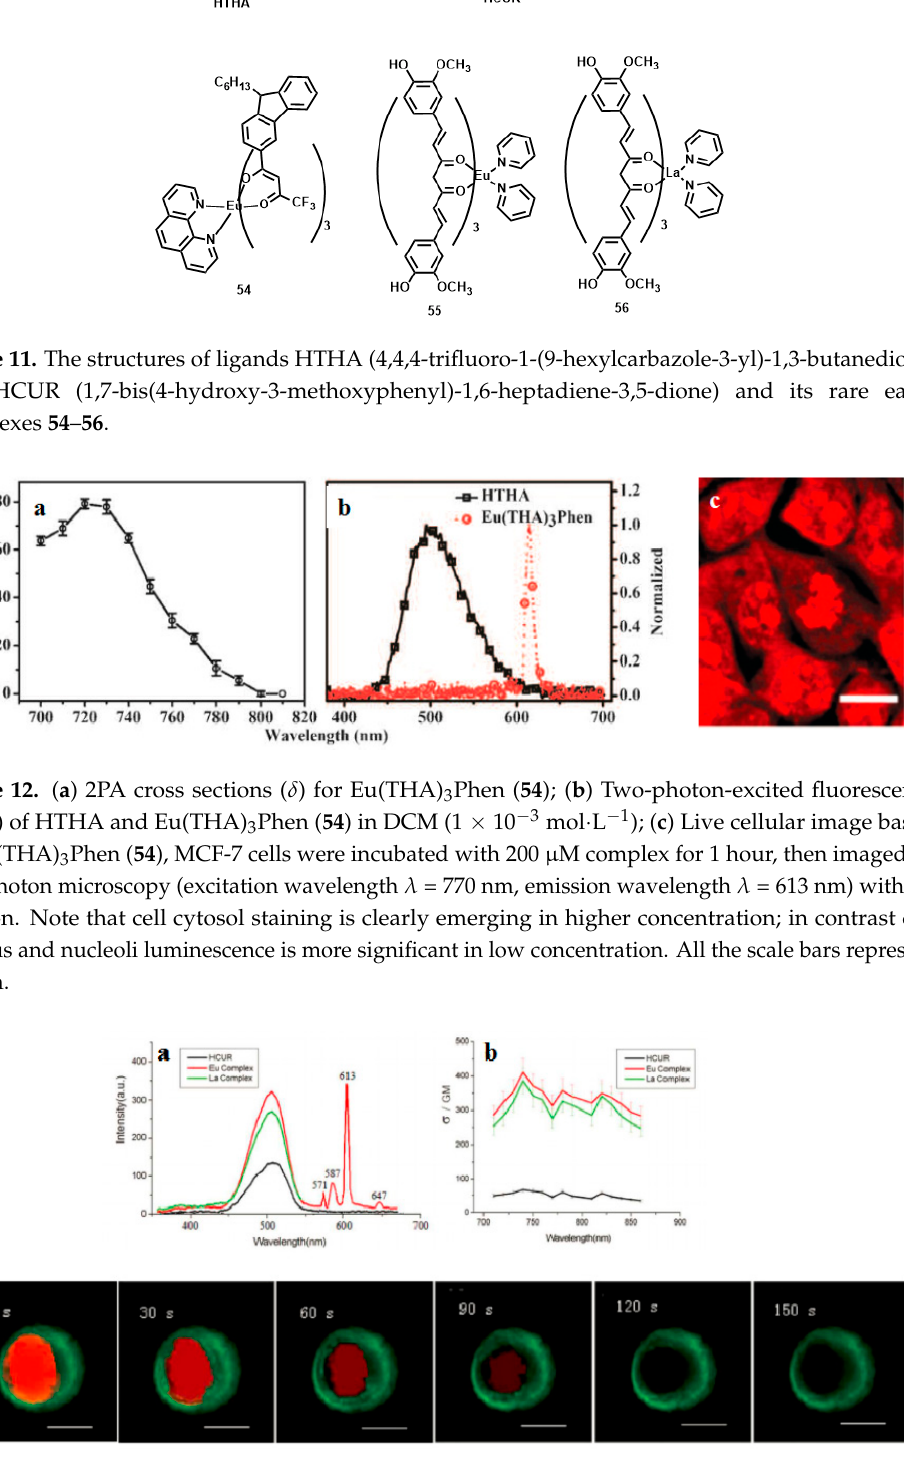
Figure 13. ( a ) Two-photon-excited fluorescence (2PEF) of HCUR, 55 and 56 in DMF (1 × 10 − 3 mol · L − 1 ); ( b ) 2PA cross sections ( δ ) for HCUR, 55 and 56 ; ( c ) The fluorescent imaging of the MCF-7 cells labeled with the 55 (green) and PI (red) at different times under continuous light exposure (all the scale bars represent 10 μ m).